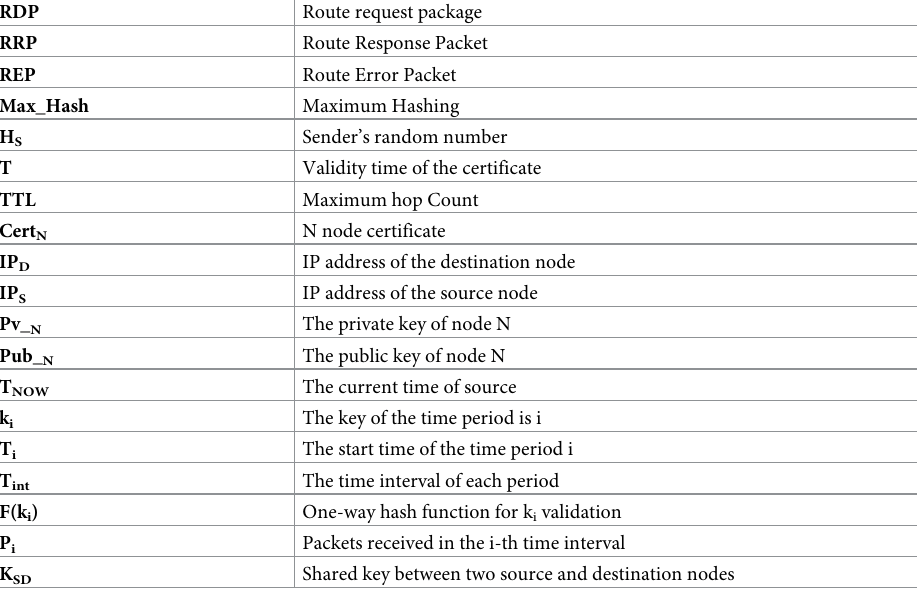
Table 1. Protocol parameters used in